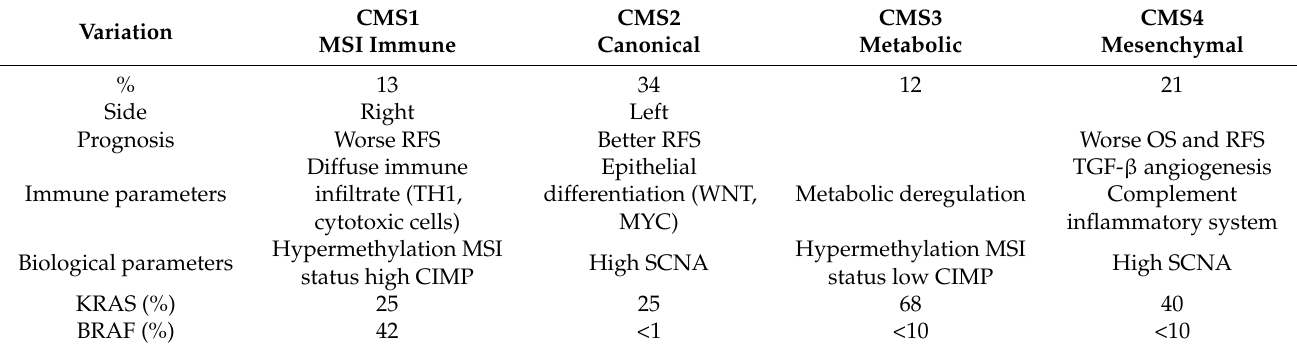
Table 1. Biological characterization and clinical prognosis of the consensus molecular